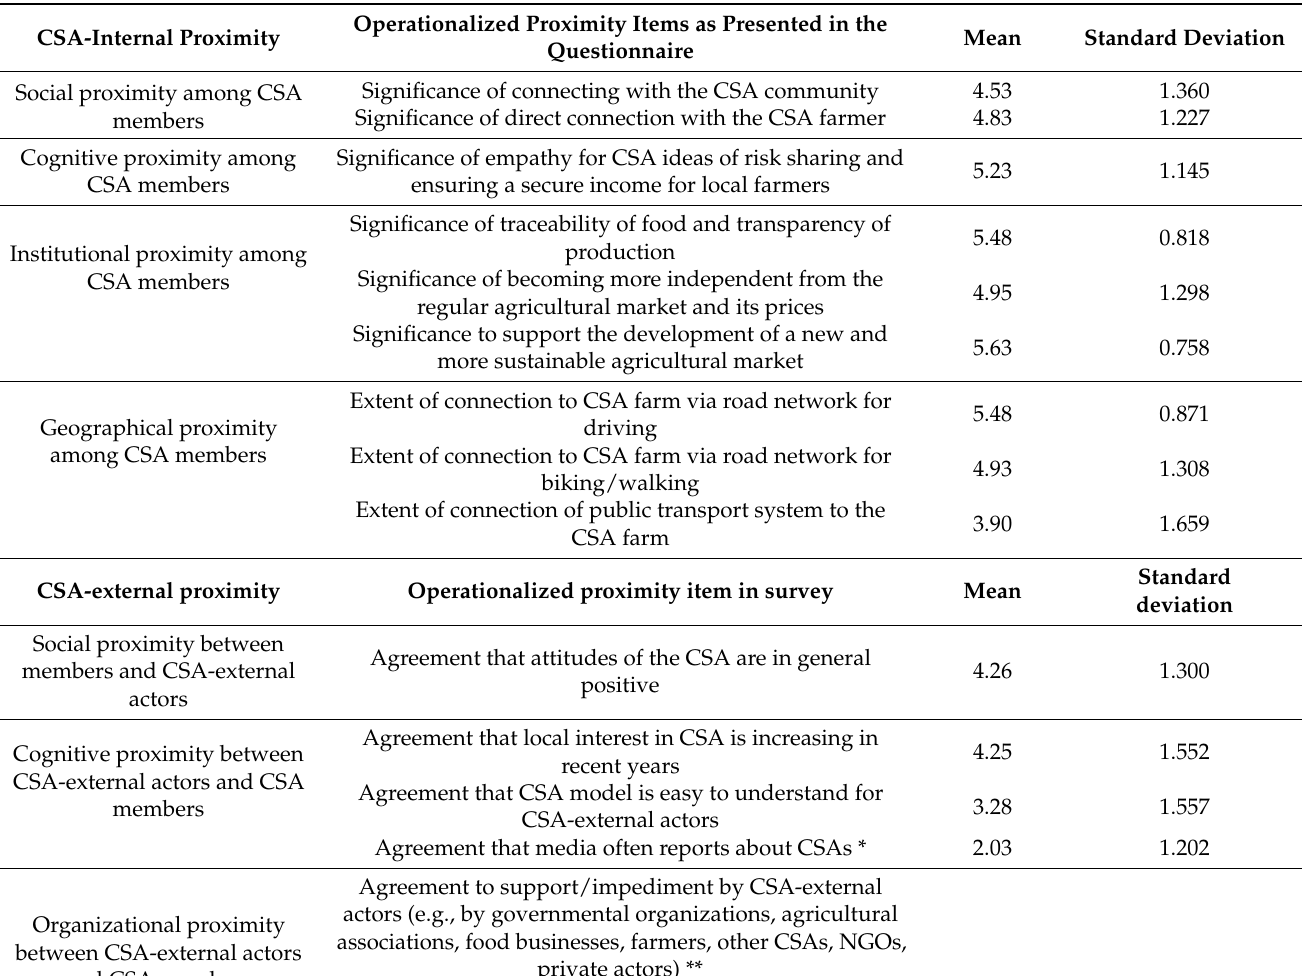
Table 3. Operationalized items of spatial–relational proximity